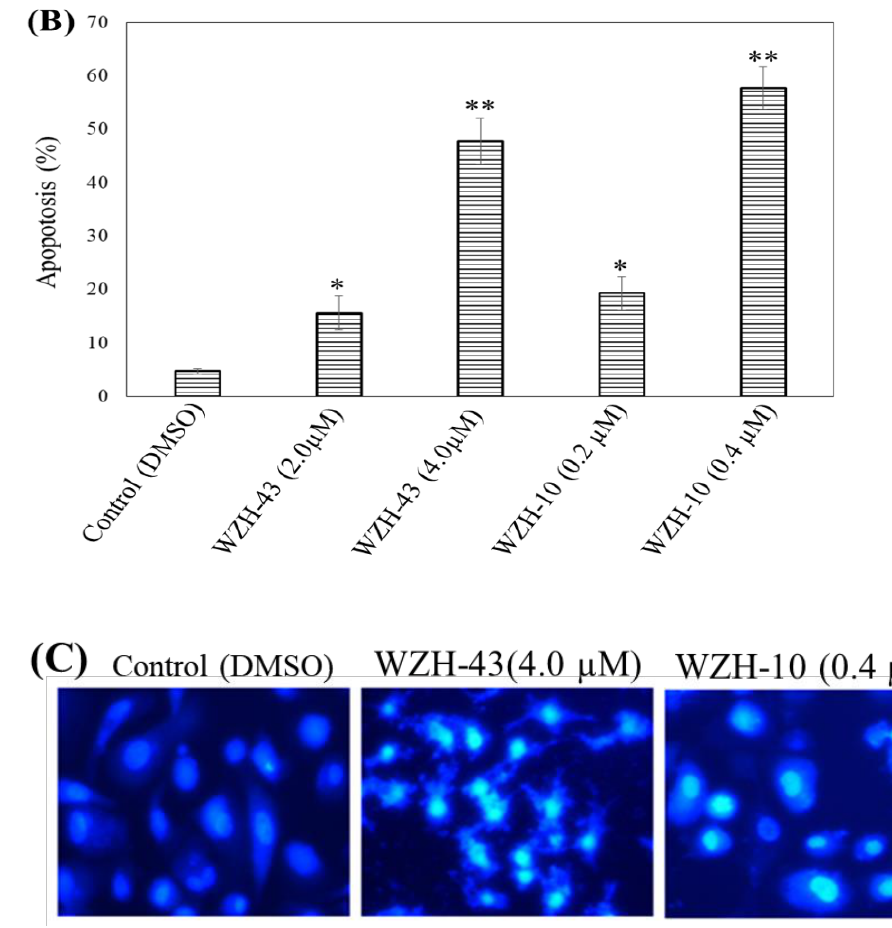
Figure 2. Cell apoptosis induced by two prenylated chalcones for 48 h. ( A ) Cell apoptosis induced by two prenylated chalcones detected with flow cytometry. ( B ) The quantification of the results in ( A ). Apoptotic cells were counted as percentage of total gated events. ( C ) Two prenylated chalcones induced apoptosis as visualized by Hoechst 33,258 staining. Chromatin condensation and fragmentation were observed by a fluorescent inverted microscope after the treatment with 4.0 µ M WZH-43 and 0.4 µ M WZH-10 for 48 h. Scale bar = 100 µ M in all images. All experiments were performed in triplicate. Results are presented as mean ± SEM. * p < 0.05, ** p < 0.01 ( n = 3) compared with the control.